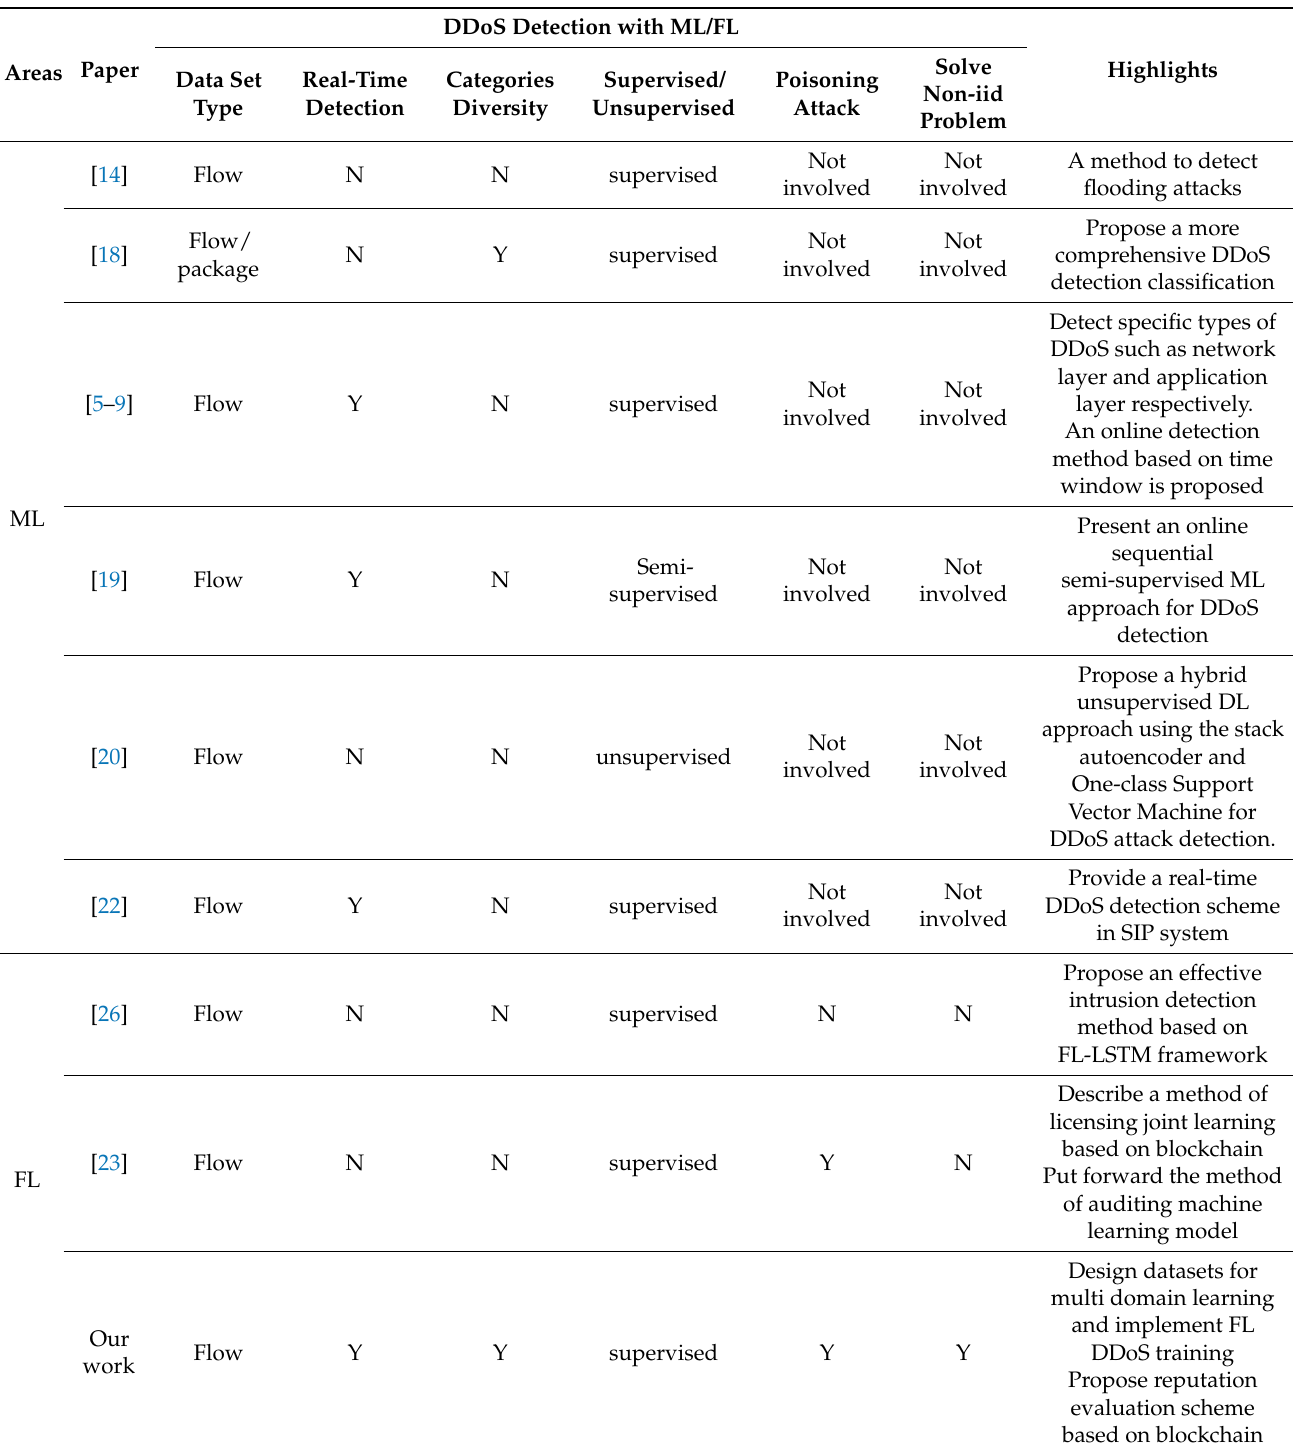
Table 1. Existing Survey on DDoS detection with ML/FL and our new